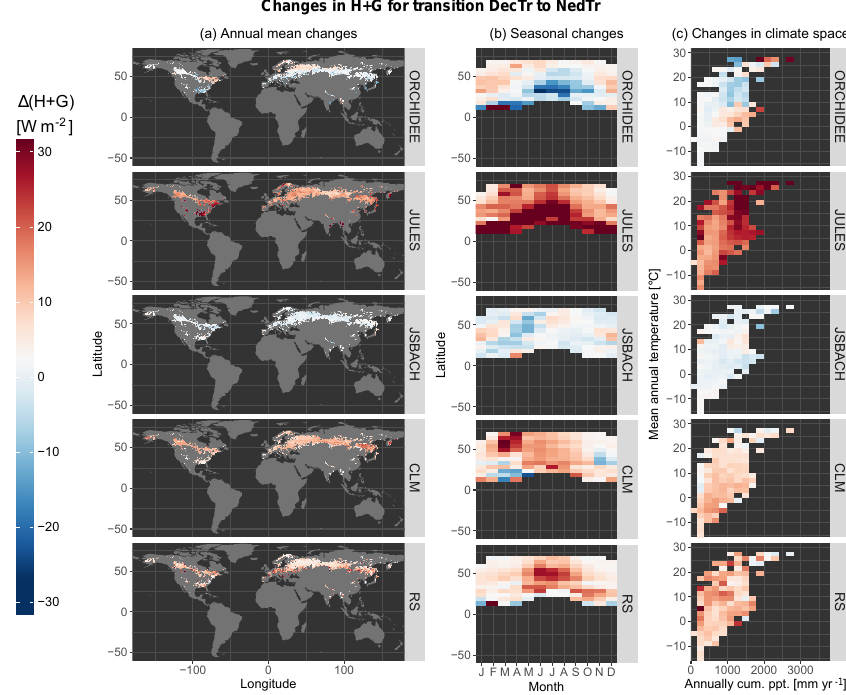
Figure 3. Same as Fig. 2 for a change in the residual flux of the energy balance composed of both sensible heat and ground heat fluxes (H + G) for the vegetation transition from deciduous broadleaf trees to needleleaf trees ( DecTr – NedTr